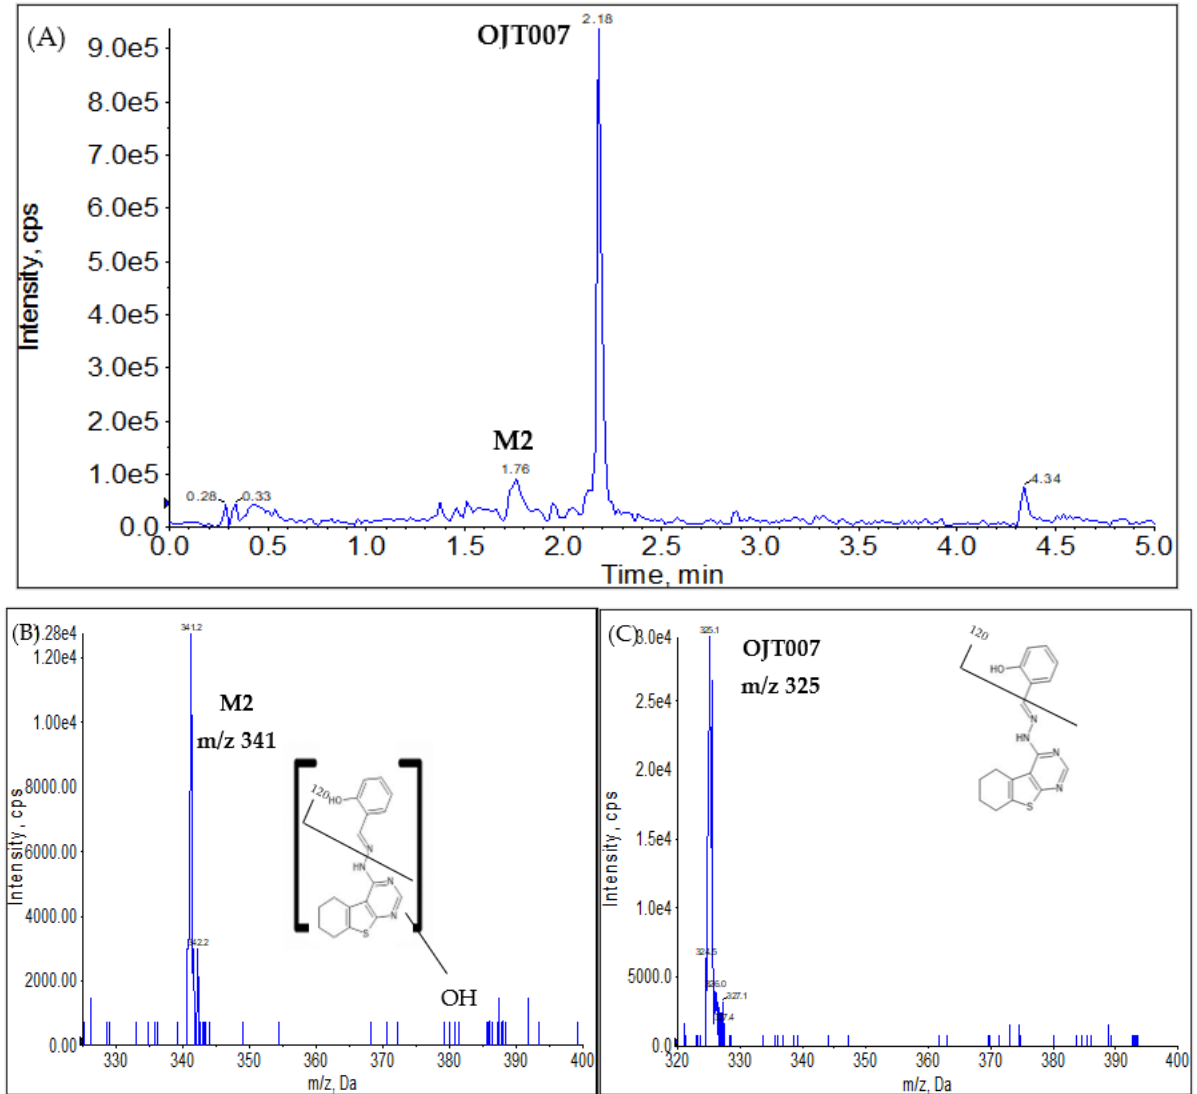
5 of 18 Figure 3. Q1MI chromatogram for m/z 341 obtained from NADPH activated liver microsomes. M1 retention time: 1.67 min; M2 retention time: 1.76 min; M3 retention time: 1.96 min. In neutral loss scans, ions are scanned on Q1, fragmented in Q2, and scanned for